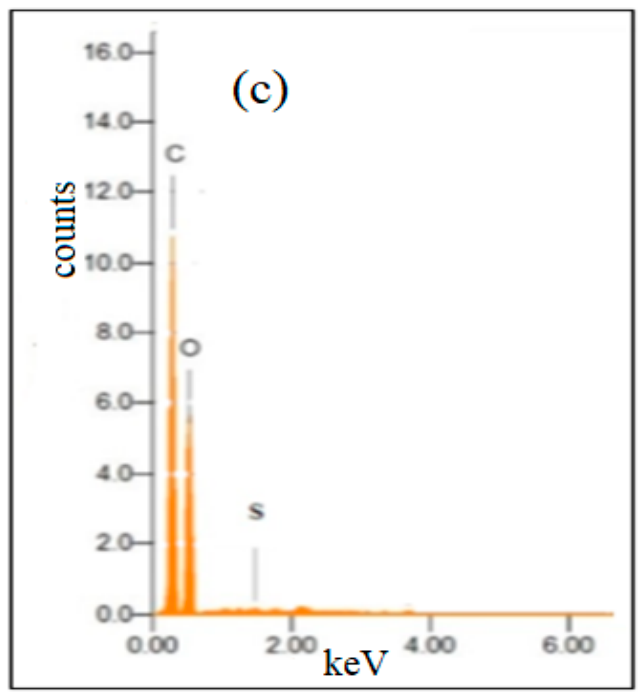
Figure 6. EDX of ( a ) raw pomegranate peels; ( b ) acid-washed; ( c ) impregnated sample.